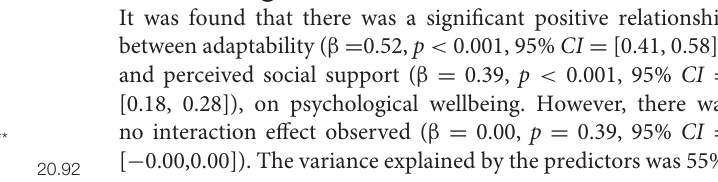
TABLE 1 | Means, standard deviations, and correlations between key variables ( N = 325).